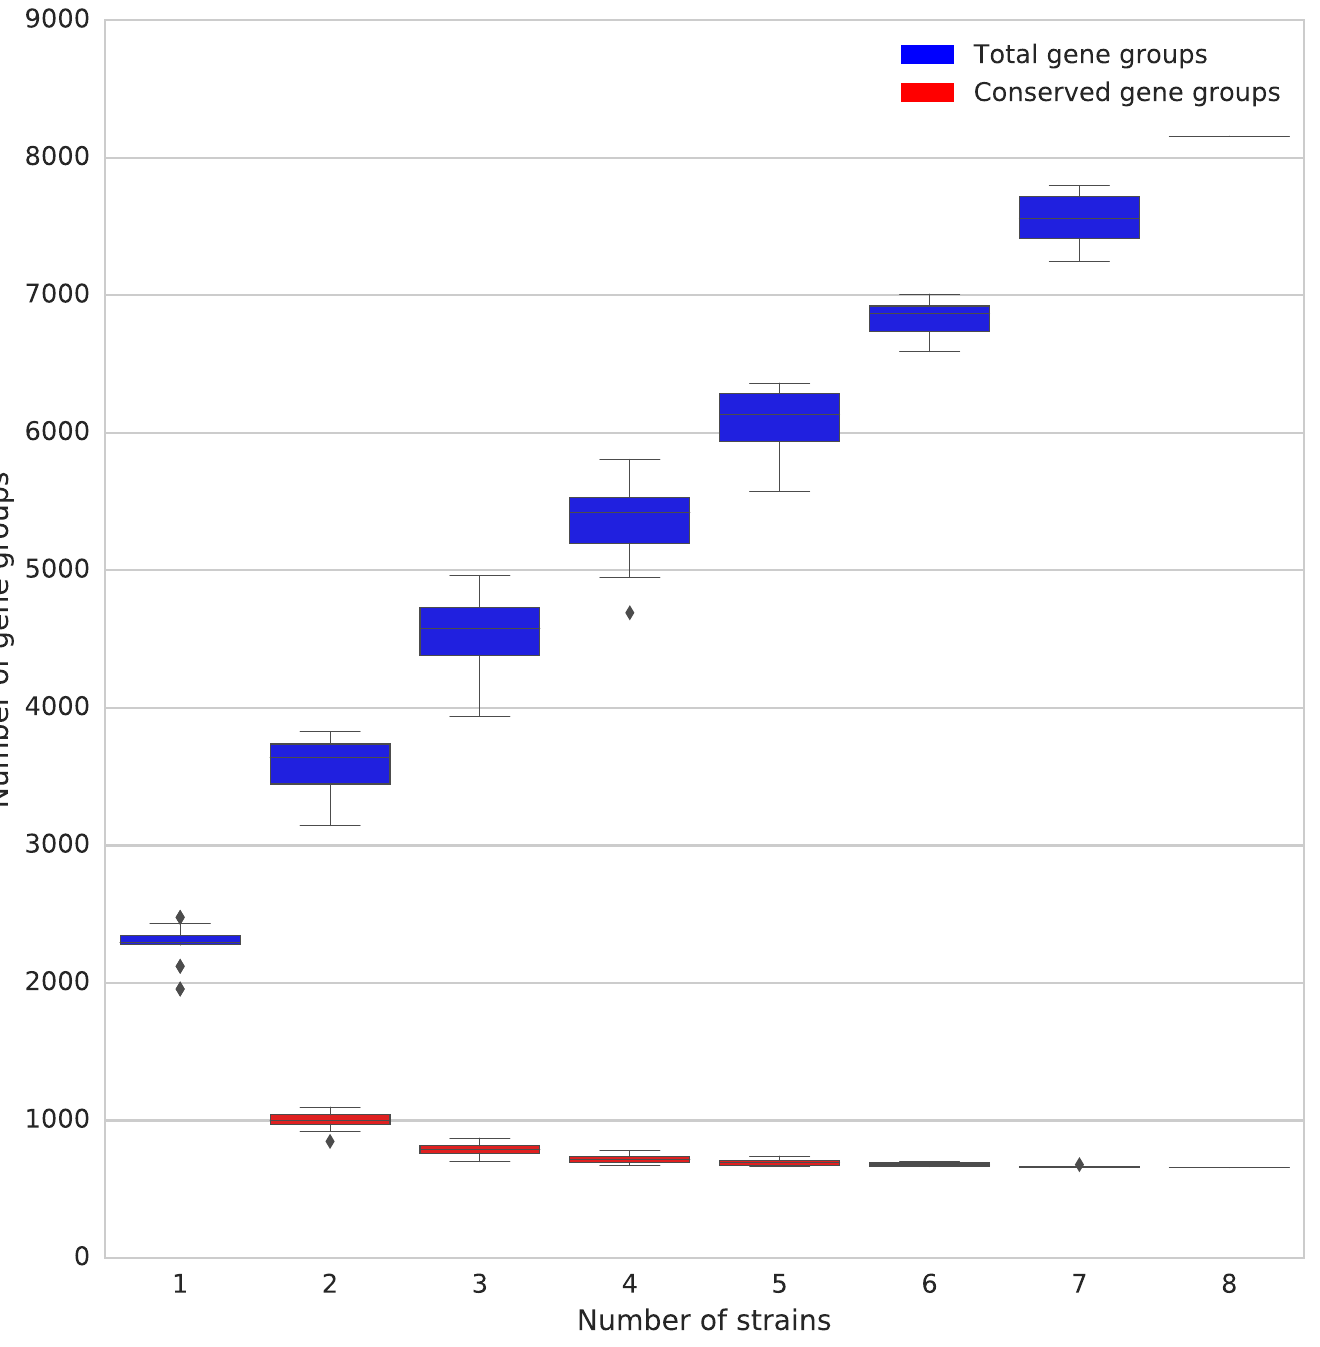
Fig 2. The number of core gene groups and the total number of gene groups (including the core gene groups) as more strains are added to the analysis. Boxplots represent all possible combinations of the number of strains given on the x-axis.